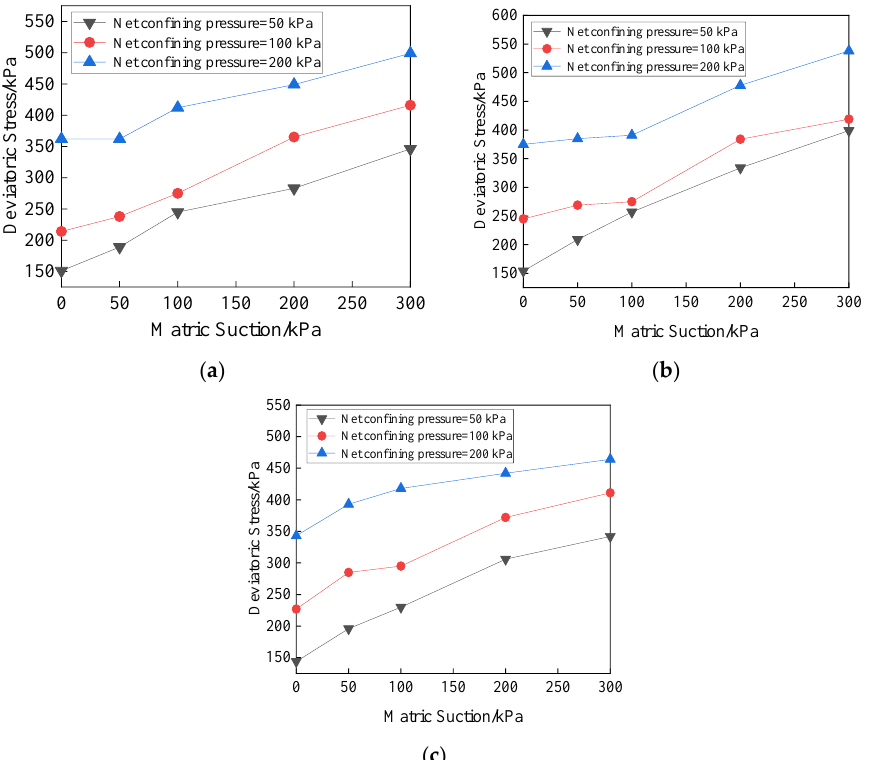
Figure 6. Relationships between matric suction and deviatoric stress with different lengths of fibers. ( a ) Fiber length = 6 mm, ( b ) Fiber length = 12 mm, ( c ) Fiber length = 19 mm. As can be seen from Figure 5, the greater the matric suction, the greater the net con- fining pressure and the deviatoric stress are. When the net confining pressure is small, the deviatoric stress increases linearly with the increase in the matric suction. When the net confining pressure is large, the increase in deviatoric stress of matric suction with short fiber reinforced specimen in the range of 100-200 kPa is greater than that in the range of 0-100 kPa. When the fiber length is 12 mm and the net confining pressure is 50 kPa, the deviatoric stress increases significantly, and it reaches 245 kPa. The matric suc- tion has a great influence on the shear properties when the net confining pressure is small. The reason is that the effective contact surface between fibers and soil particles and among soil particles is small, a lot of free water – air interface in soil will form a meniscus water membrane, which produces matric suction affecting soil properties. The change in matric suction is directly related to the number of shrinkage membranes in soil, so the soil strength is sensitive to the change in matric suction. When the net confining pressure is large, the soil particles are arranged densely, the friction between fibers and soil parti-